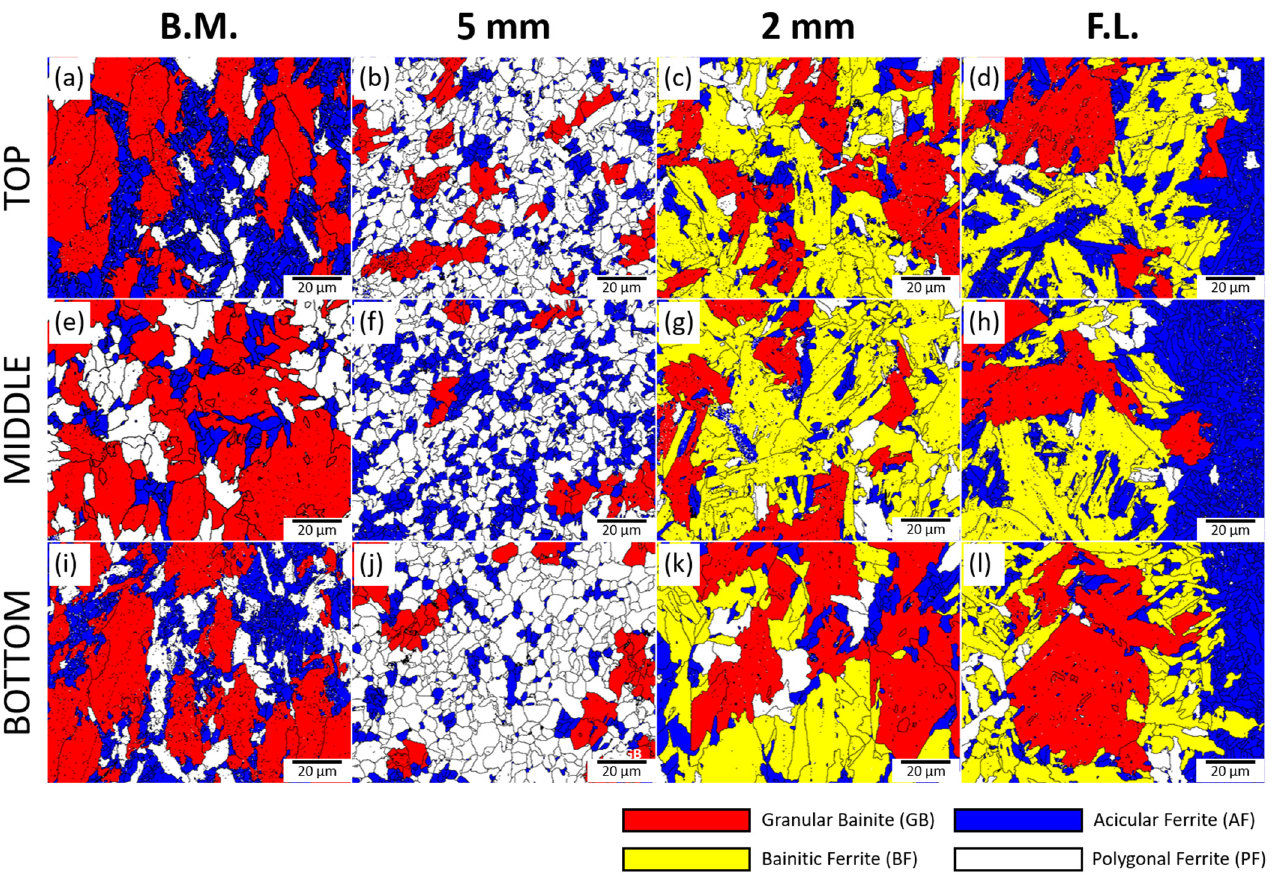
Figure 6. Phase analysis of base metal and HAZ according to grain orientation spread (GOS): ( a ) base metal, ( b ) 5 mm from F.L., ( c ) 2 mm from F.L., ( d ) F.L. of top; ( e ) base metal, ( f ) 5 mm from F.L., ( g ) 2 mm from F.L., ( h ) F.L. of middle; ( i ) base metal, ( j ) 5 mm from F.L., ( k ) 2 mm from F.L., ( l ) F.L. of bottom.